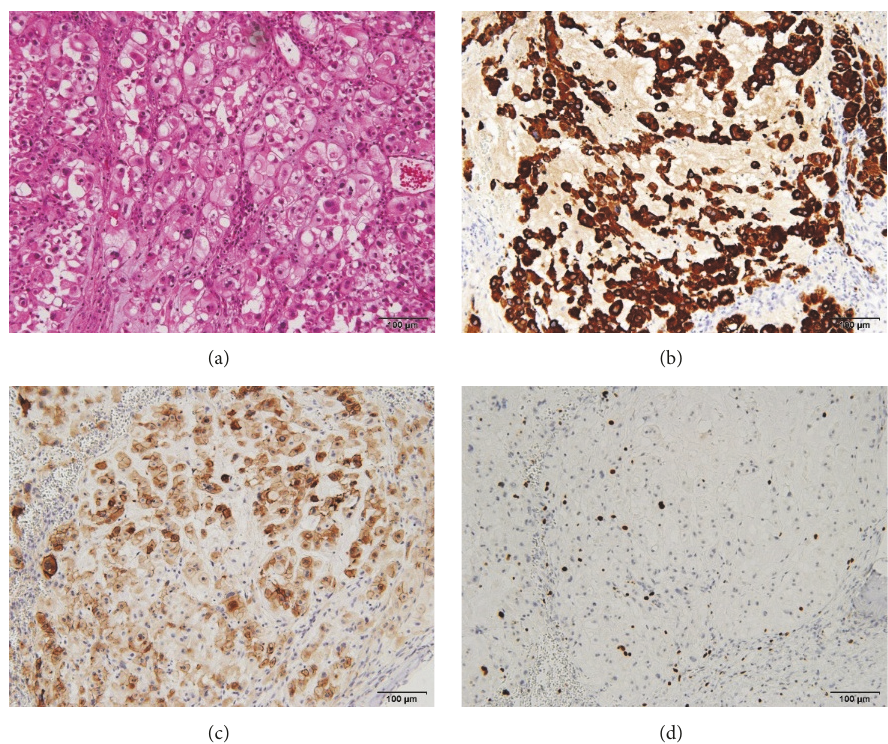
Figure 3: Histological and immunohistochemical features of the tumor. (a) Hematoxylin and eosin stain showing pathognomonic physaliphorous cells with multivacuolated cytoplasm. The appearance of chordoma consists of cords and islands of tumor cells arrayed in a distinctly lobular fashion, with mucus-filled cytoplasm. (b, c, d) The tumor cells demonstrating positive immunostaining with AE1/AE3 (b), epithelial membrane antigen (EMA) (c), and KI-67 expression (d). Scale bar of all the panels: 100 𝜇